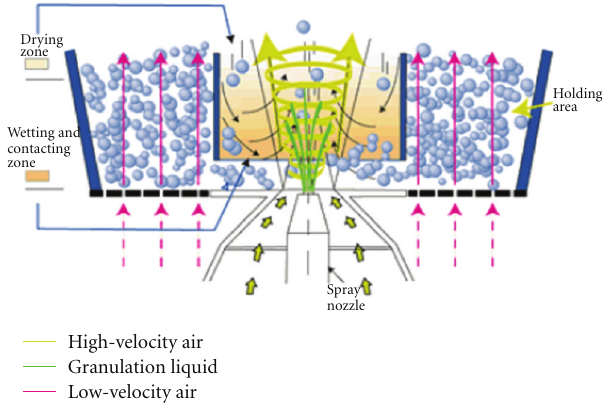
Figure 1: Schematic of precision coating process.